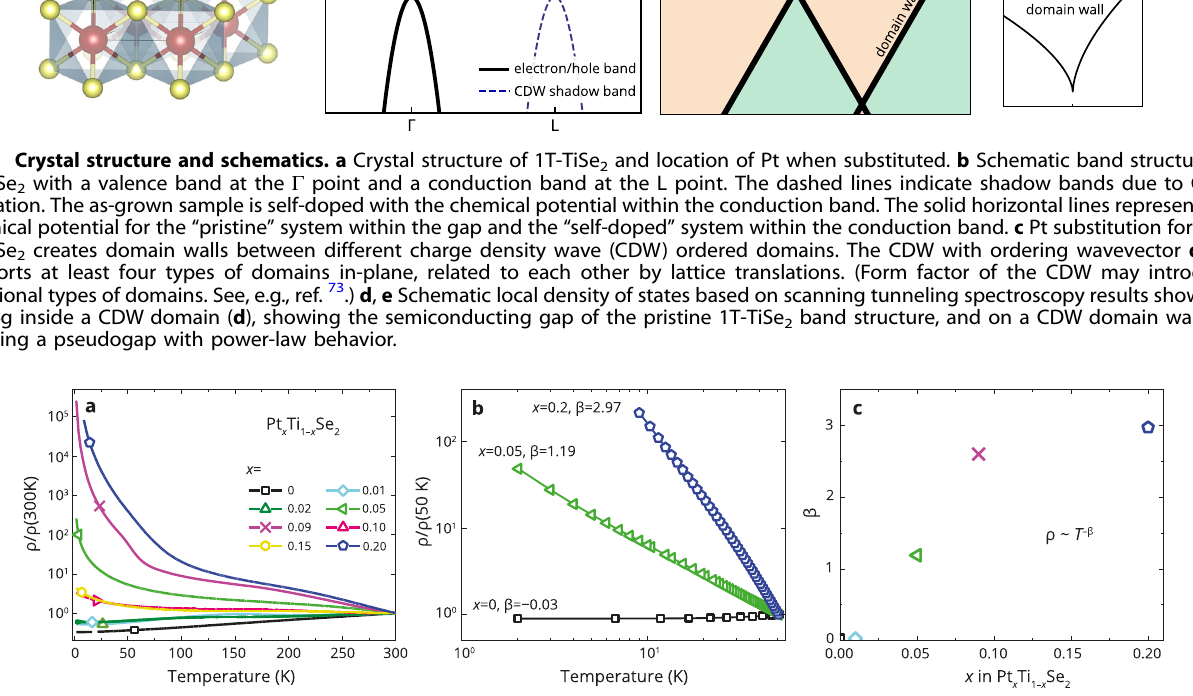
ARPES. Figure 3a, d show the energy-momentum intensity maps (EMIMs) 15 around the L point for x = 0.1 and x = 0, respectively. The EMIM depicts the ARPES intensity as a function of one of the in-plane momentum components and electronic energy ω referenced to the chemical potential μ , while keeping the other orthogonal in-plane momentum component fi xed. Both samples show a hole-like band near the Γ point and its CDW shadow near the L point. Compared to that of the x = 0 sample, the shadow band of the x = 0.1 sample is much weaker and broader, indicating the loss of long-range CDW correlation with doping.